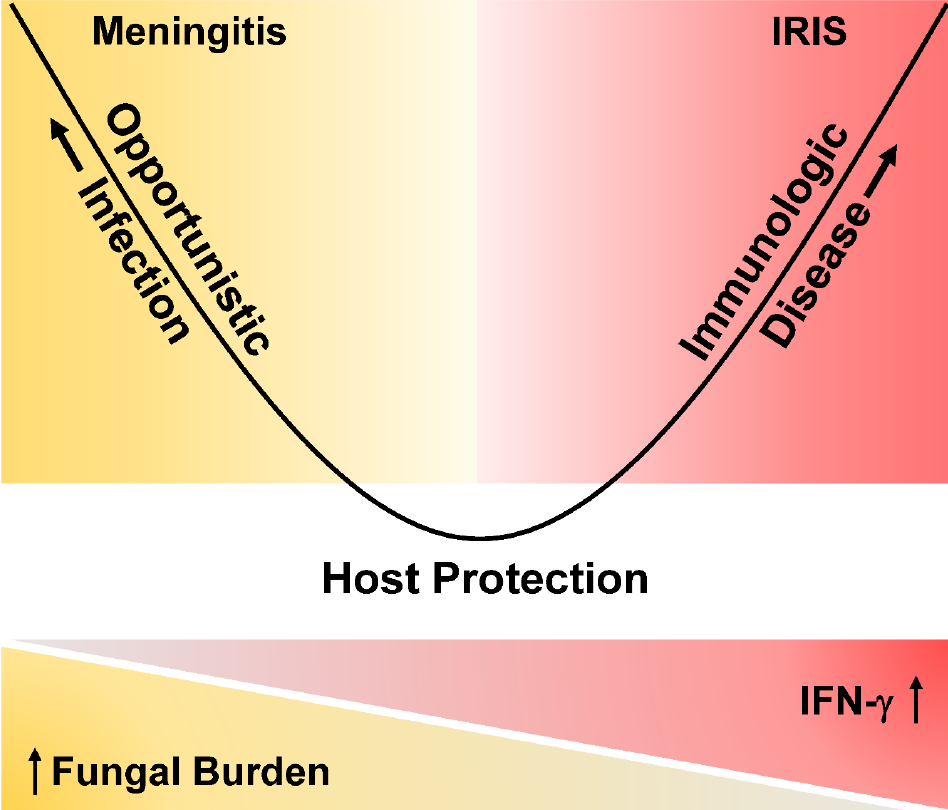
Figure 2. Simplified Damage-Response Parabolic Framework Model of Cryptococcal Meningitis Disease. Figure 2 demonstrates a hypothesized damage-response model for HIV-associated cryptococcal disease. The model proposes that clinical disease can occur by either of two mechanisms: (1) Uncontrolled fungal dissemination characterized by suboptimal IFN - γ predominated Type 1 helper (Th 1 ) response with increasing CSF quantitative culture burden, or (2) Excessive damaging host immune response characterized by exaggerated IFN - γ predominated Th 1 host response with persons presenting with sterile CSF cultures. The host is most likely protected by a moderate, balanced immune response. (Figure is originally adapted from Pirofski and Casadevall concept, and further modified from our prior publication [29]).